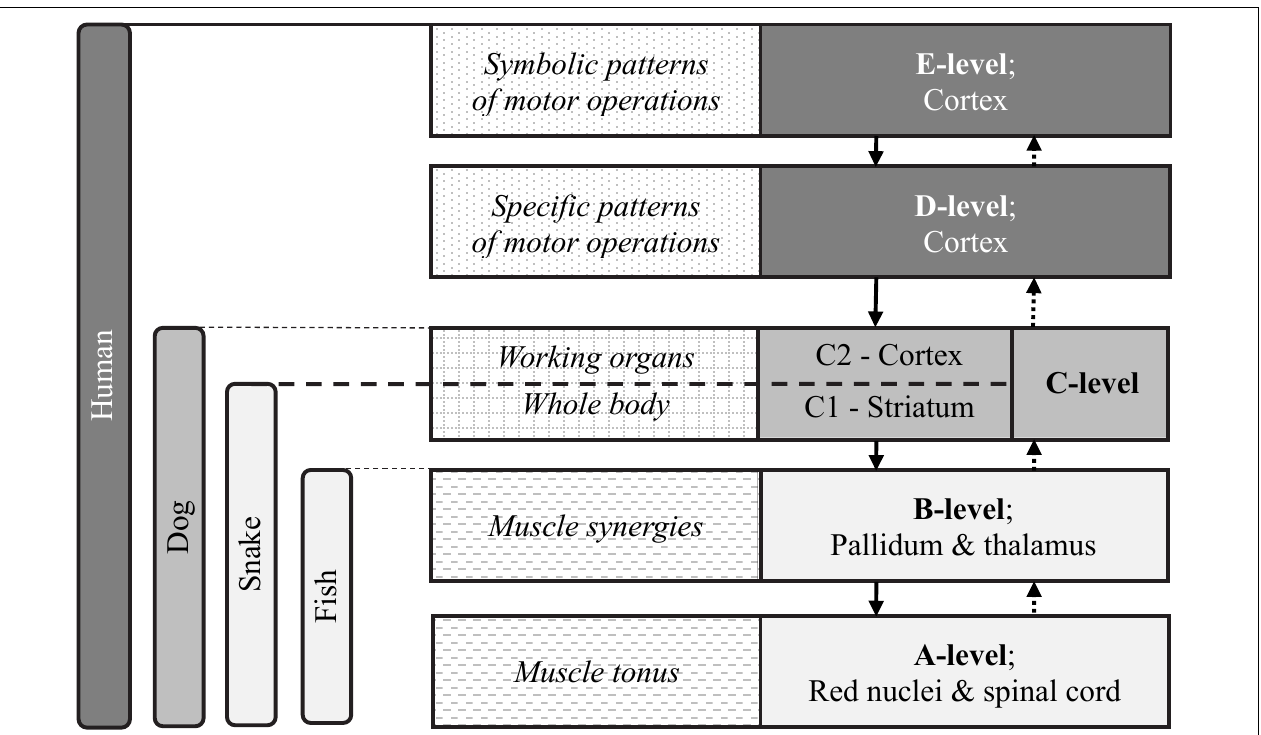
FIGURE 1 | The “brain skyscraper” according to N. A. Bernstein (Petry´nski, 2008, p. 166; Petry´nski, 2016a, p. 25,